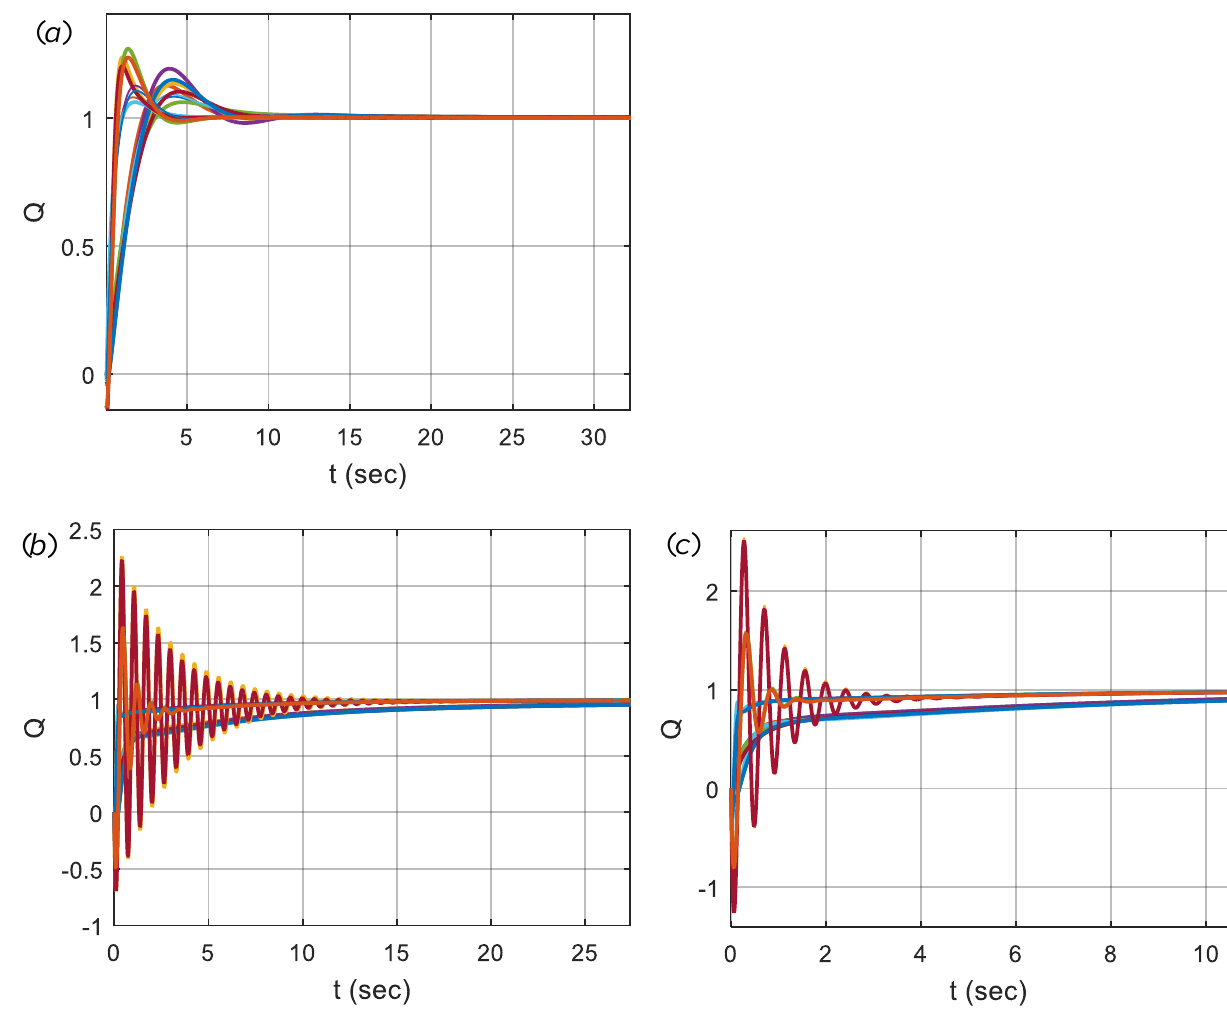
, ( b ) for φ T 2 = 3 π and 60 40